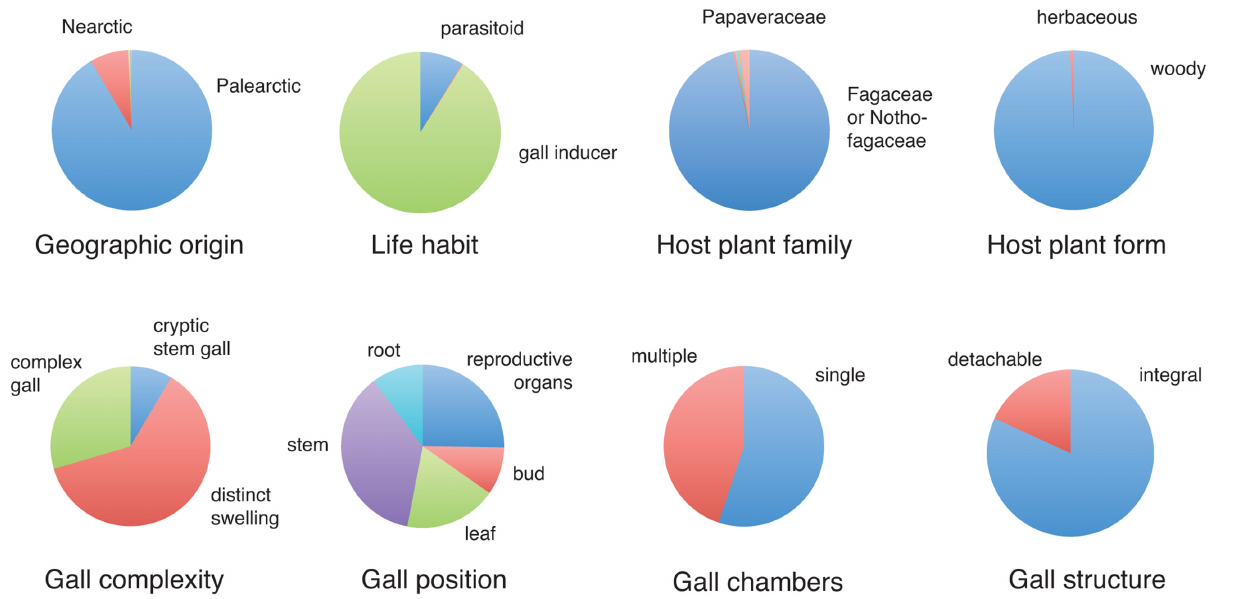
Fig 6. Posterior probability of various biological traits in the ancestor of extant Cynipidae. Note that the ancestor was unlikely to have been an inquiline according to this analysis (PP 0.002).